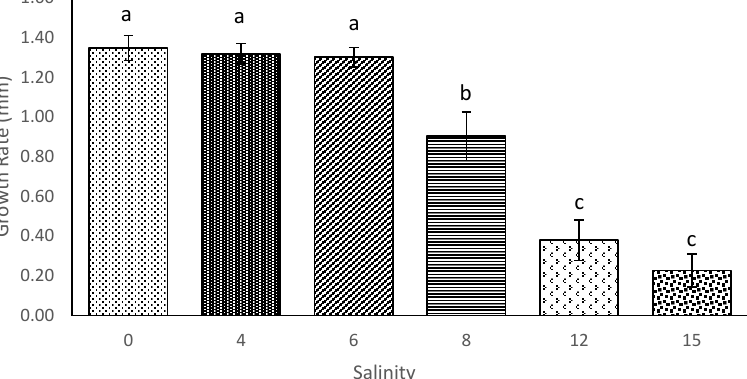
Figure 4. The growth rate of M. macrocopa for different salinity treatments. The different small letters indicate significant differences between different salinity treatments ( p < 0.05).